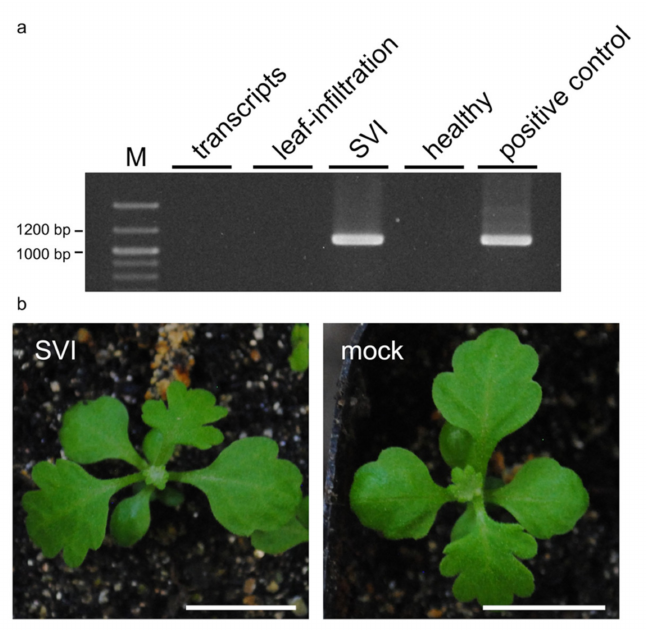
Figure 1. Efficient inoculation method of tomato aspermy virus (TAV) into Chrysanthemum seticuspe . ( a ) RT–PCR detection of TAV in C. seticuspe inoculated with the TAV cDNA clone. M, DNA size marker; the transcripts, leaf infiltration, and SVI indicate that RNA was extracted from the C. seticuspe inoculated by the mechanical inoculation of viral transcripts, agroinoculation into leaves, and vacuum infiltration into sprouts, respectively; healthy, healthy plant; positive control, RNA extracted from the Nicotiana benthamiana inoculated with TAV-ChJ. ( b ) C. seticuspe plants that the TAV was detected at 28 days postinoculation (dpi) (SVI). Mock plants were inoculated with a pJL89 binary vector by SVI. Bars, 10